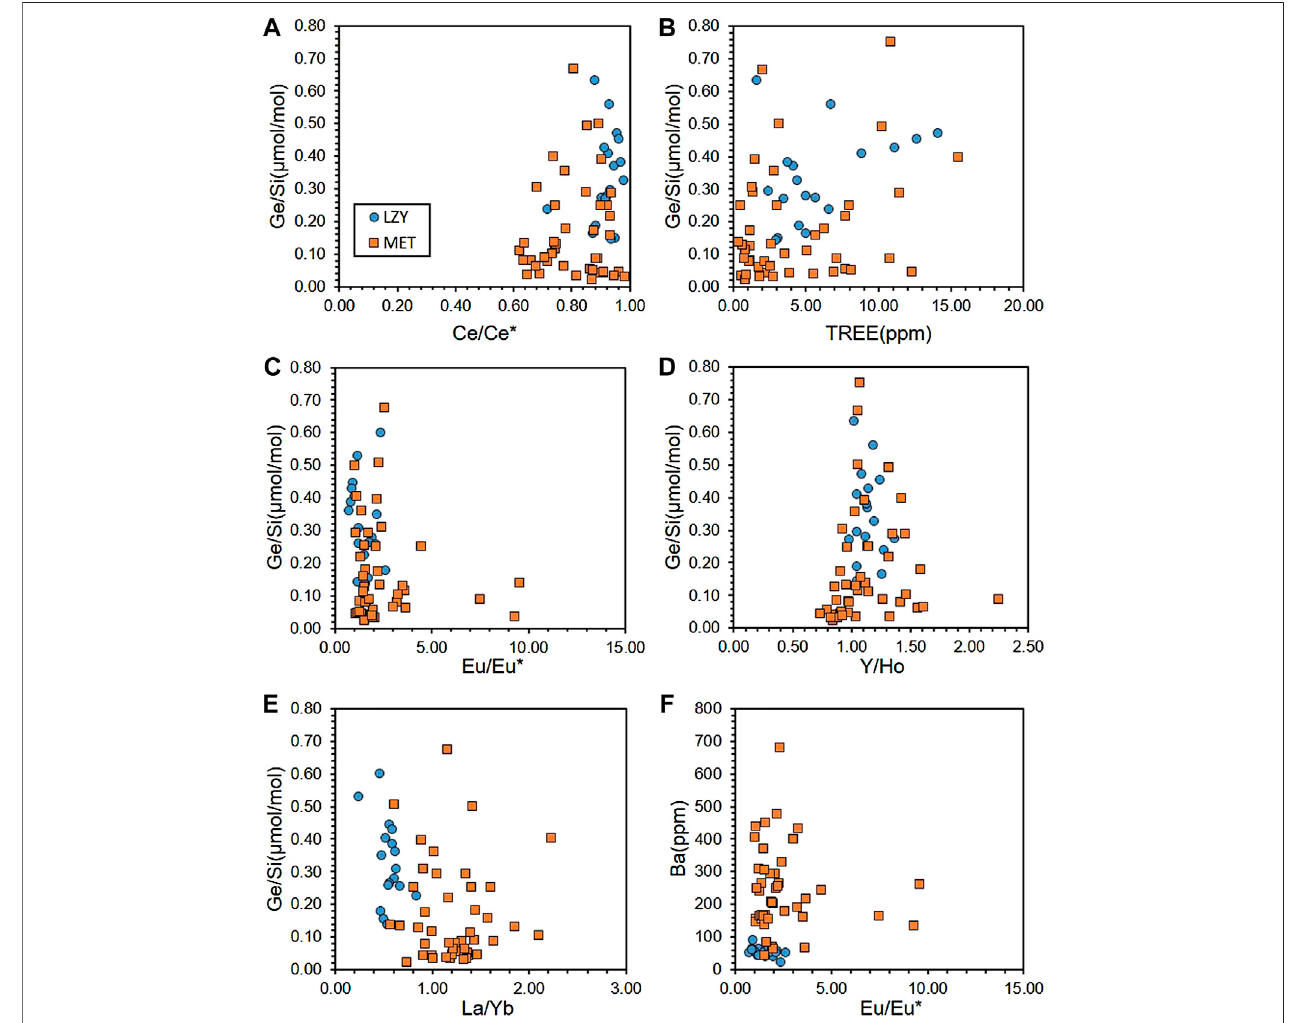
FIGURE 7 | Cross plots showing the correlations between (A) Ge/Si ( μ mol/mol) vs. TREE (ppm); (B) Ge/Si ( μ mol/mol) vs. Ce/Ce*; (C) Ge/Si ( μ mol/mol) vs. Eu/Eu*; (D) Ge/Si ( μ mol/mol) vs. Y/Ho; (E) Ge/Si ( μ mol/mol) vs. La/Yb, and (F) Ba (ppm) vs. Eu/Eu*.